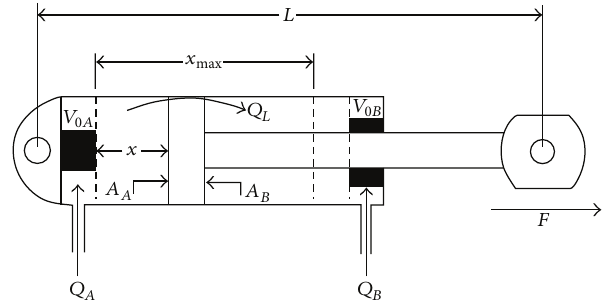
Figure 3: Differential double acting cylinder [34].